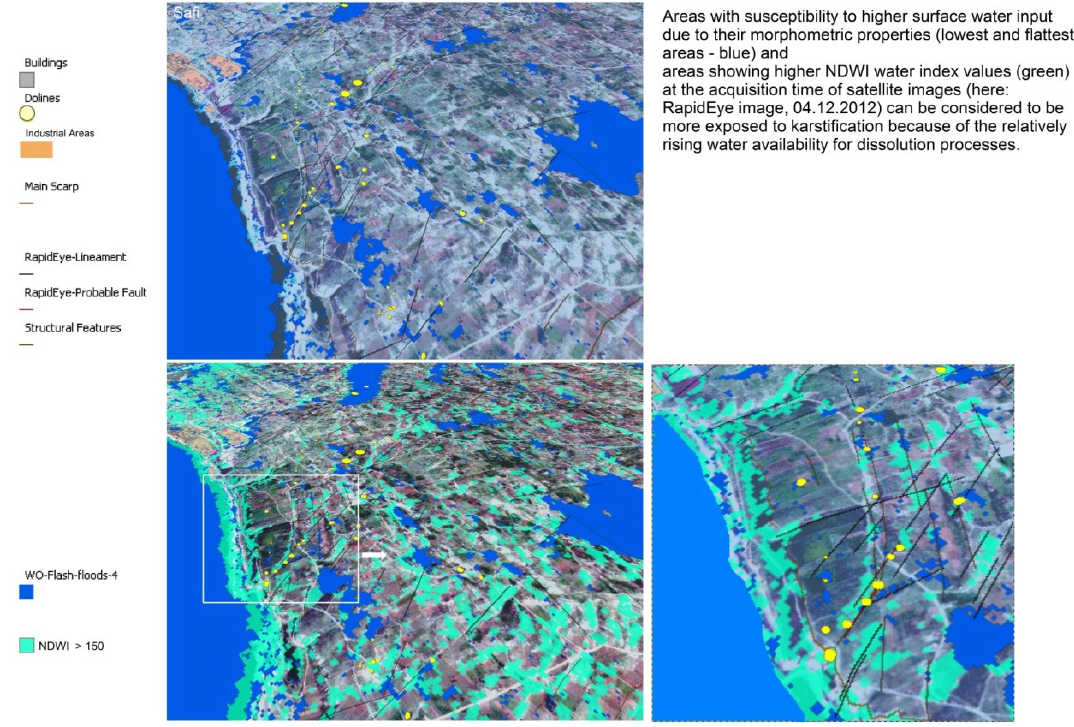
Figure 19. Higher NDWI values (green) calculated based on RapidEye data, indicating areas with higher soil moisture, combined with the weighted overlay results for the detection of areas susceptible to higher surface water flow (blue).